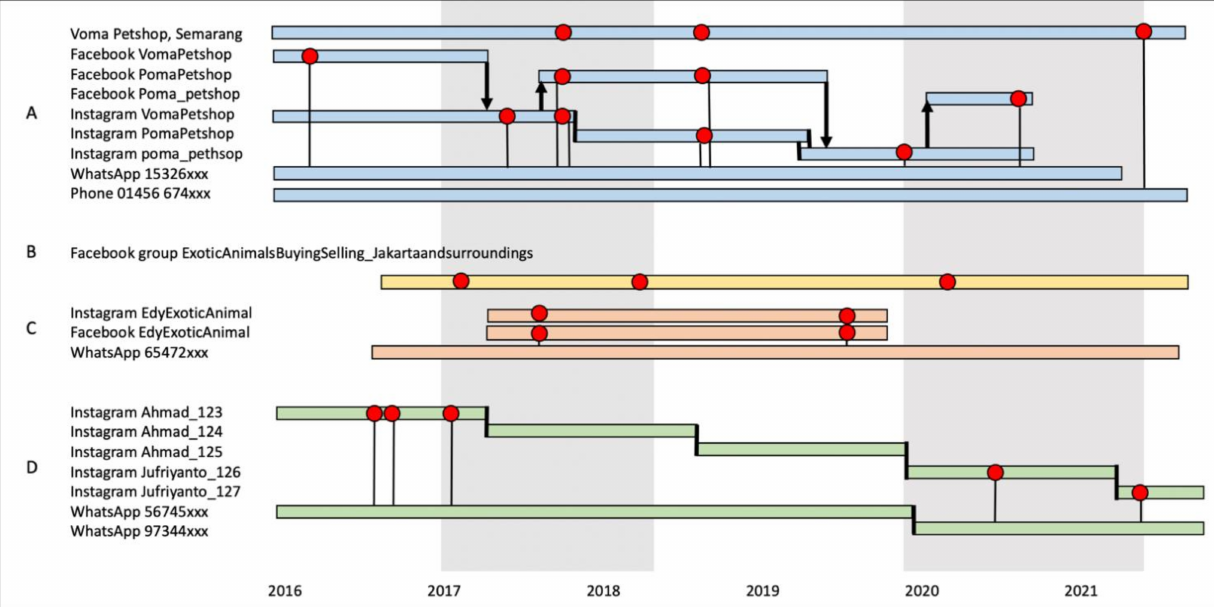
Figure 1. Mechanisms of offering apes (and other wildlife) for sale via social media and how brick-and-mortar shops, Facebook pages, Facebook groups, Instagram accounts and WhatsApp are linked to continue to sell legally protected wildlife. Red circles denote an ape for sale; arrows denote a referral to a new platform, and thin lines indicate reference to WhatsApp messenger or phones. Our active monitoring periods are in gray. Types A, B, C and D refer to the text. All names are pseudonymized and are representations of typical naming conventions. Note that many Indonesians do not distinguish (in writing or in speech) between a “P” and a “V” or an “F”; the change from Voma to Poma is thus a small one. Note the spelling change from “petshop” to “pethsop”. Achmad Jufriyanto Tohir is an Indonesian professional footballer who plays for the top club Persib Bandung; a change from Ahmad to Jufriayanto is one that is easy to remember.